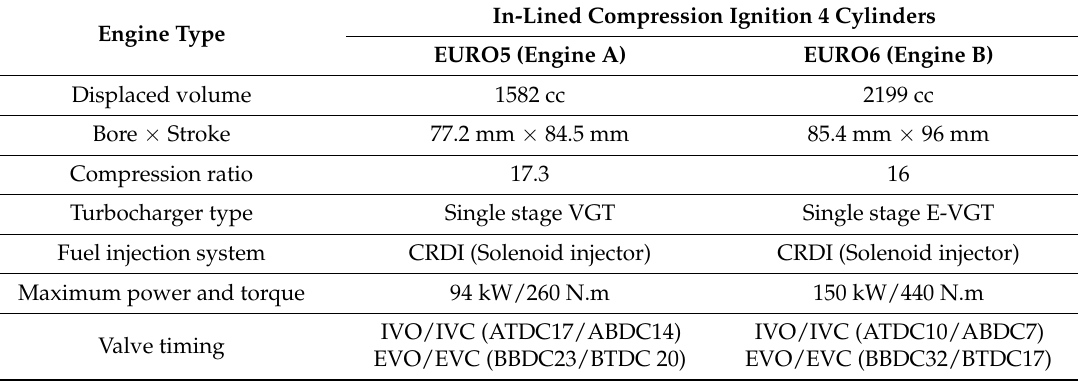
Table 1. Key specifications of the test